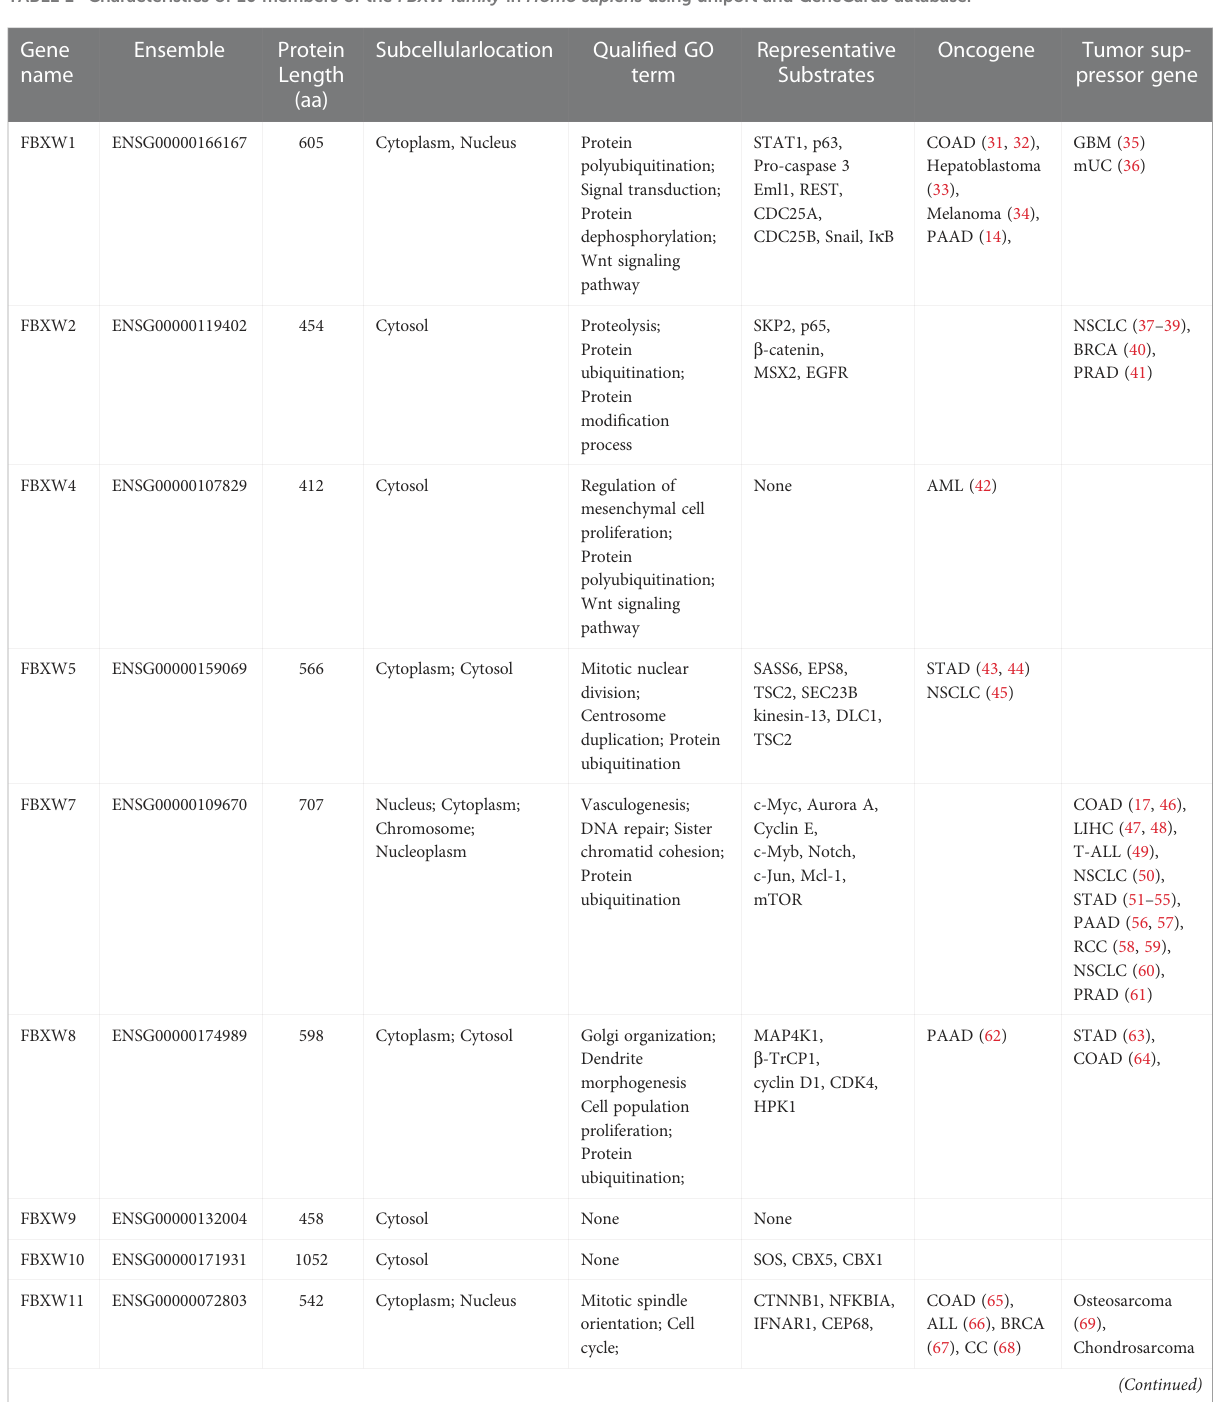
TABLE 1 Characteristics of 10 members of the FBXW family in Homo sapiens using uniport and GeneCards